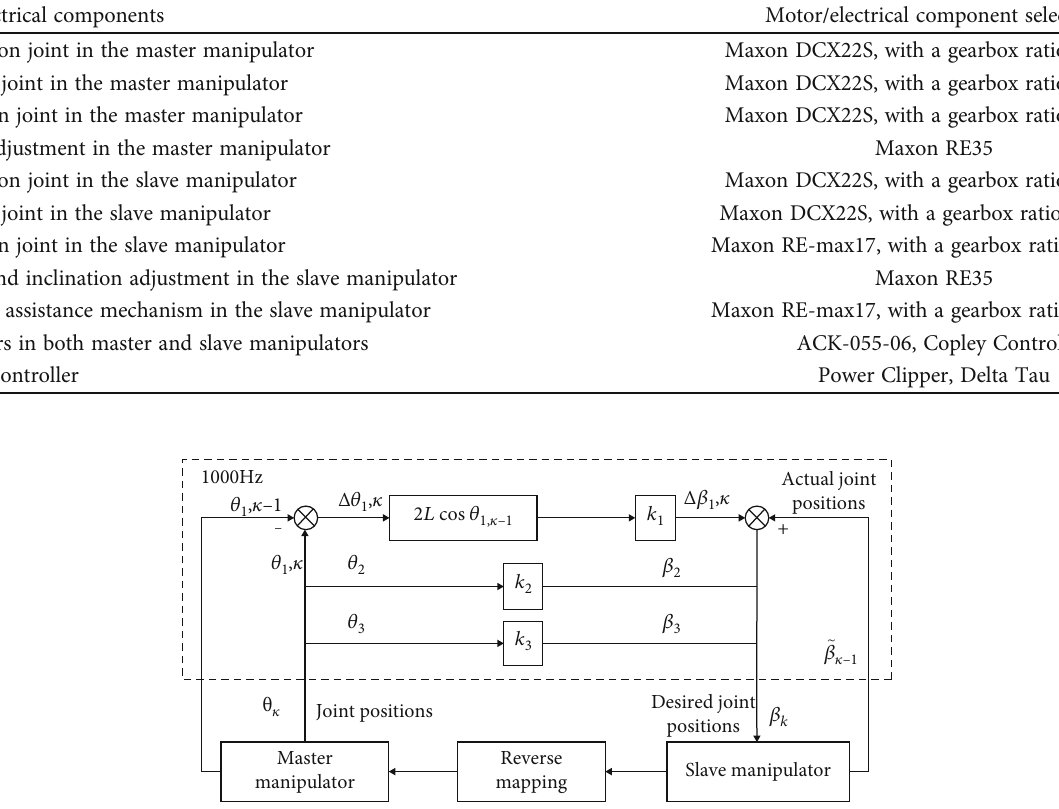
Figure 11: The applied joint-to-joint control strategy of the robotic system.